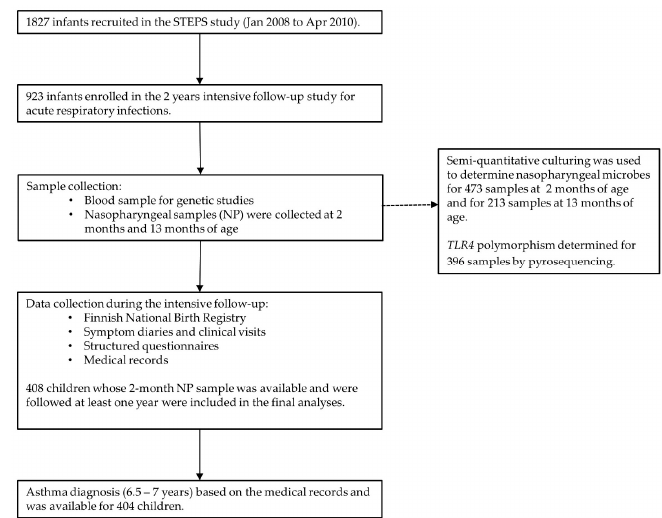
Figure 1. Layout of the study design and sample collection during the follow up.